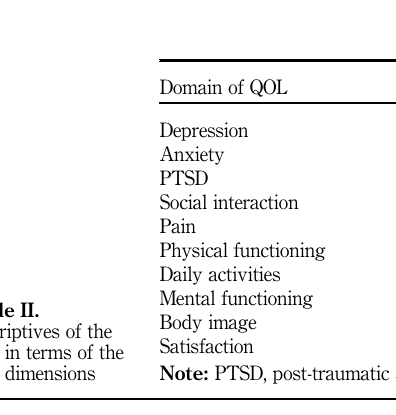
characteristics including gender, age, marital status, education level, return to work, injury severity score, injury region and time since trauma injury